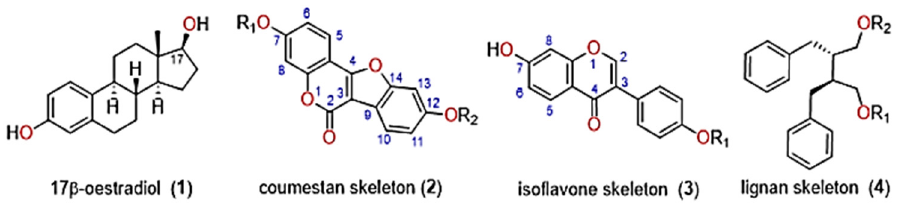
Figure 1. 17 β -estradiol ( 1 ) and the key classes of phytoestrogens, coumestans ( 2 ), isoflavones ( 3 ) and lignans ( 4